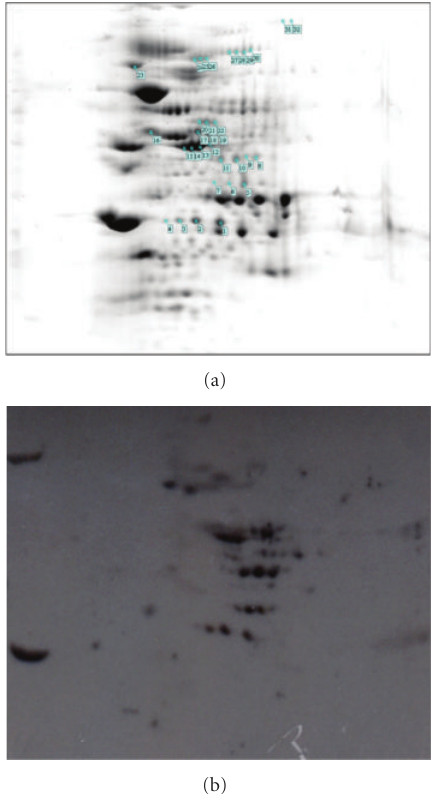
Figure 9: Two-dimensional gel analysis of L. interrogans PLG binding proteins. Leptospiral total cell lysates were separated by isoelectric point (pH 3–10) and molecular mass on 12% SDS- PAGE. Replicate gels were Coomassie Blue stained (a) or transferred to membranes and submitted to PLG a ffi nity immunoblotting (b). The reactive spots are enumerated on (a). The results are representative of three independent experiments performed in duplicates.